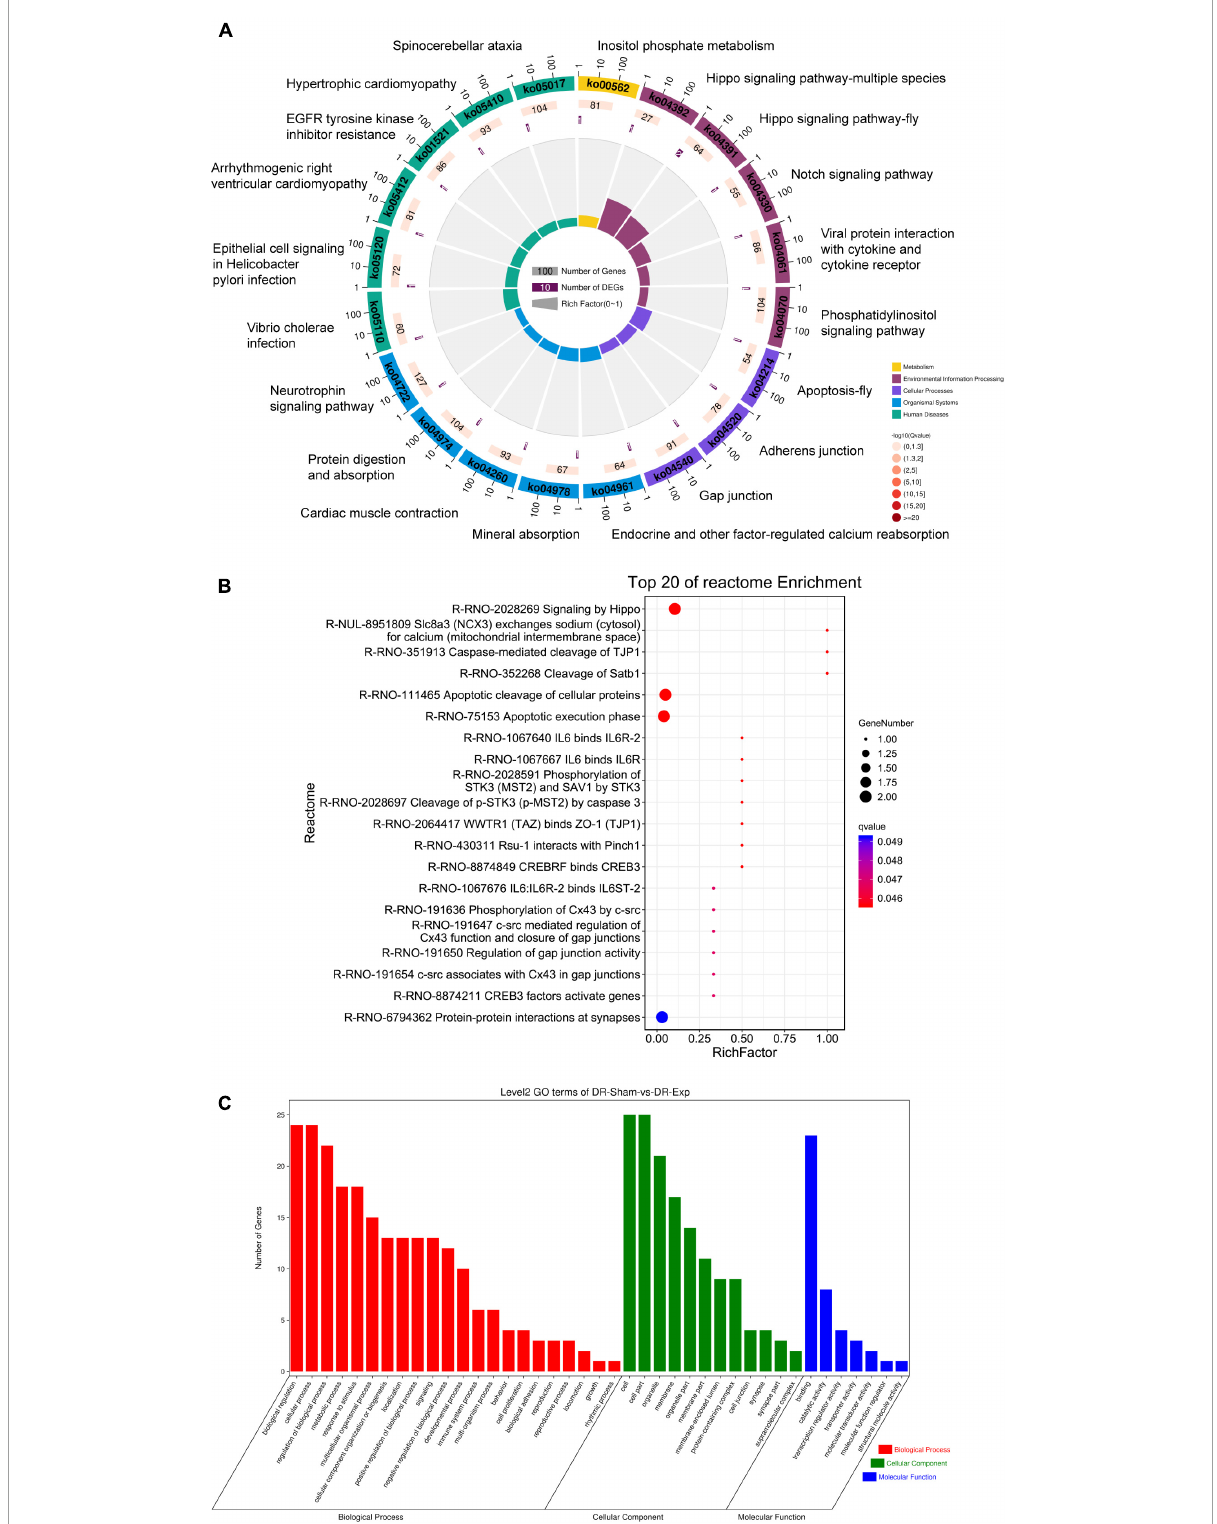
FIGURE5 Annotation of host genes of differentially expressed circular RNAs after rat central axon injury. Enriched (A) KEGG pathways, (B) reactome pathways, and (C) GO